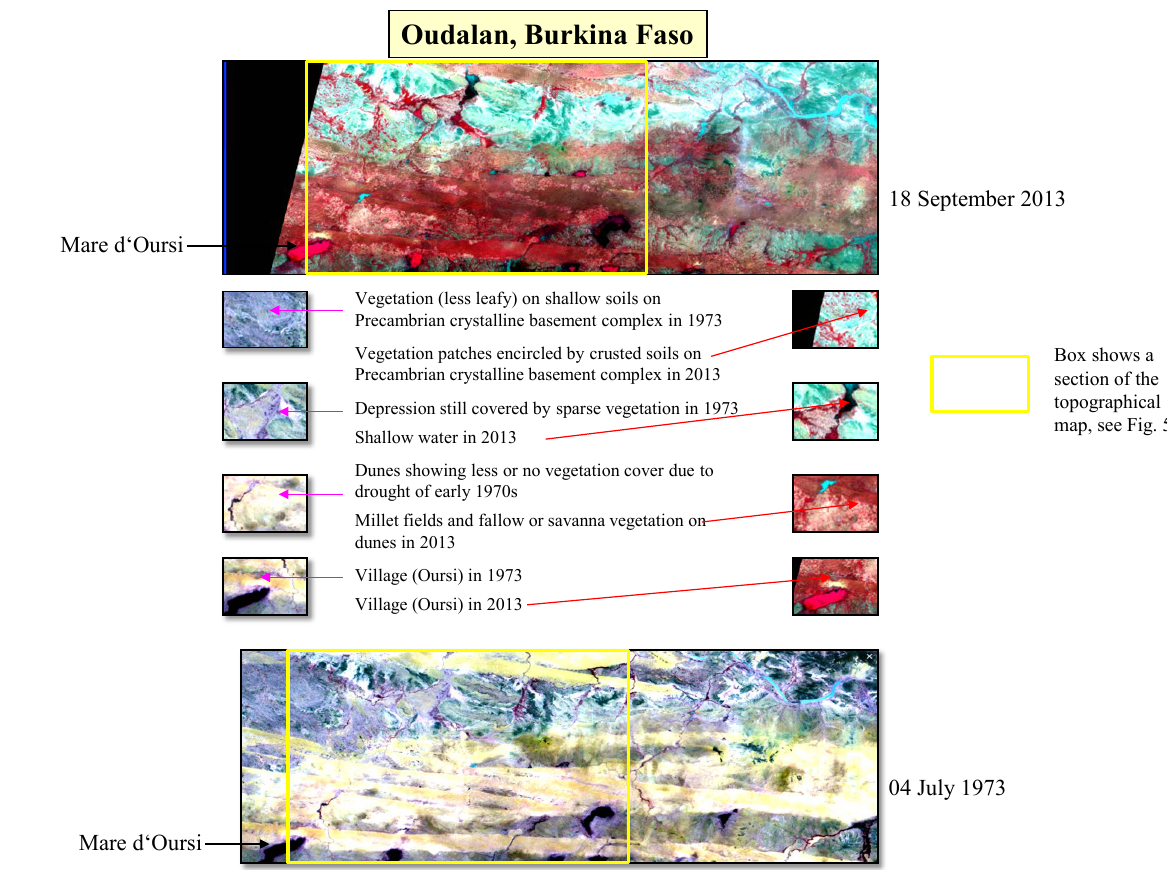
Figure 4. The Landsat subsets from eastern Burkina Faso cover an area of approx. 70km × 30km.